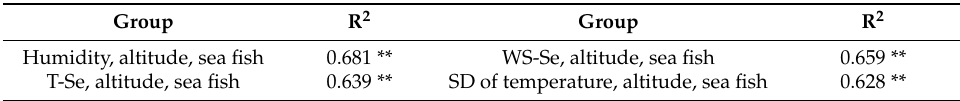
Table 7. Regression coefficient of the top four groups with highest R 2 of GWR in